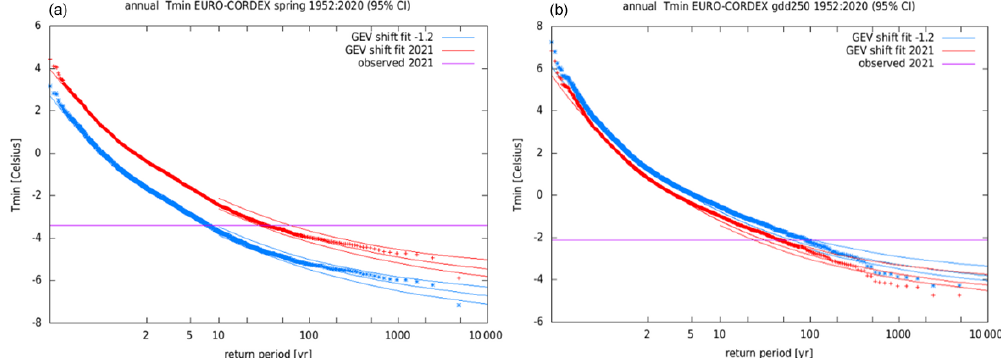
Figure 6. Return value vs. return period for EURO-CORDEX and the indices TNnApr–Jul (a) and TNnGDD250 (b) averaged over the study area (the rectangle shown in Fig. 2b). The observed values from E-OBS are marked by the purple line. Note however that the observed values were not the values used to calculate the probability ratio of the event in the EURO-CORDEX ensemble, as the ensemble has a bias toward higher